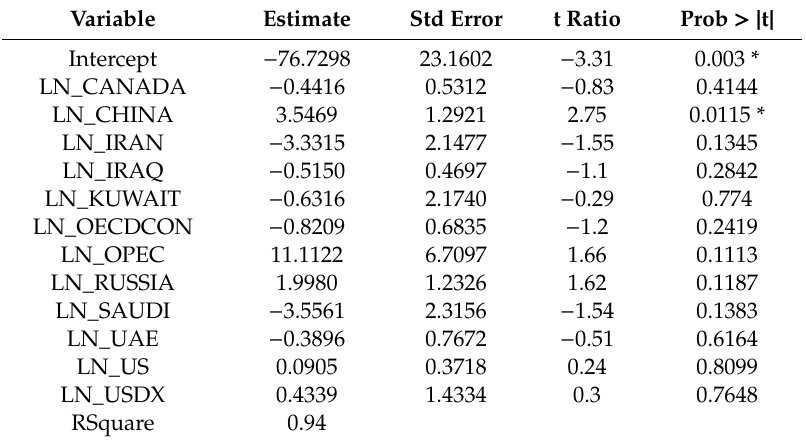
Table 10. Panel 3 period (2004–2006): LN_BRENT prediction-parameter estimation.